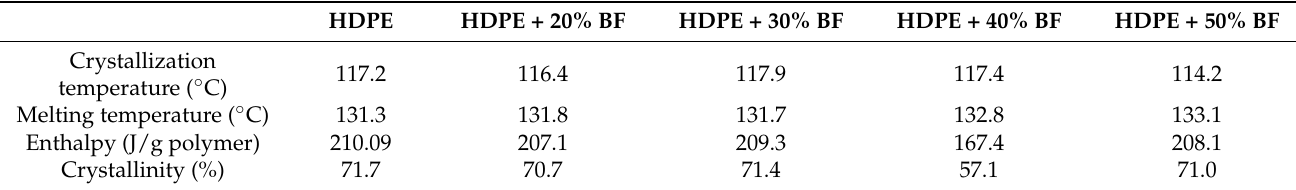
Table 3. Thermal transition data of HDPE and HDPE/BF composites.